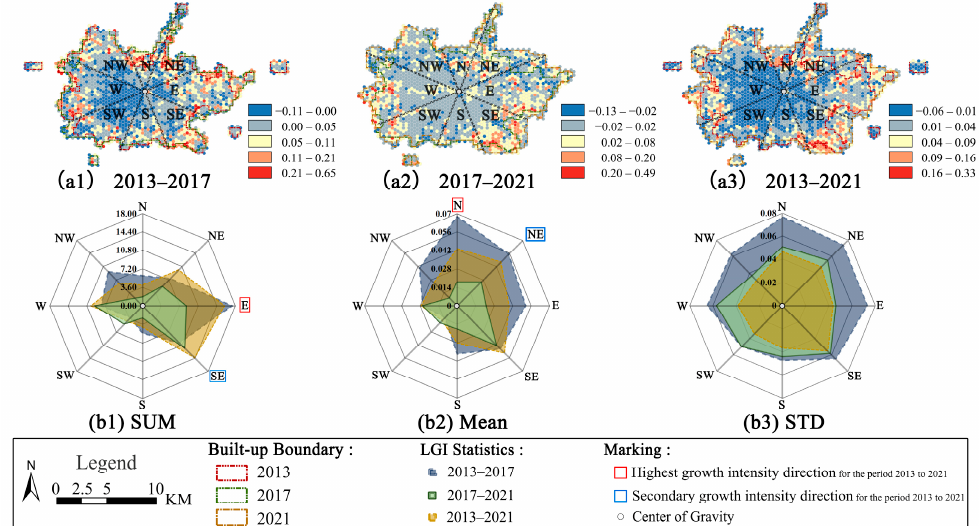
Figure 4. Trend analysis of LCI.